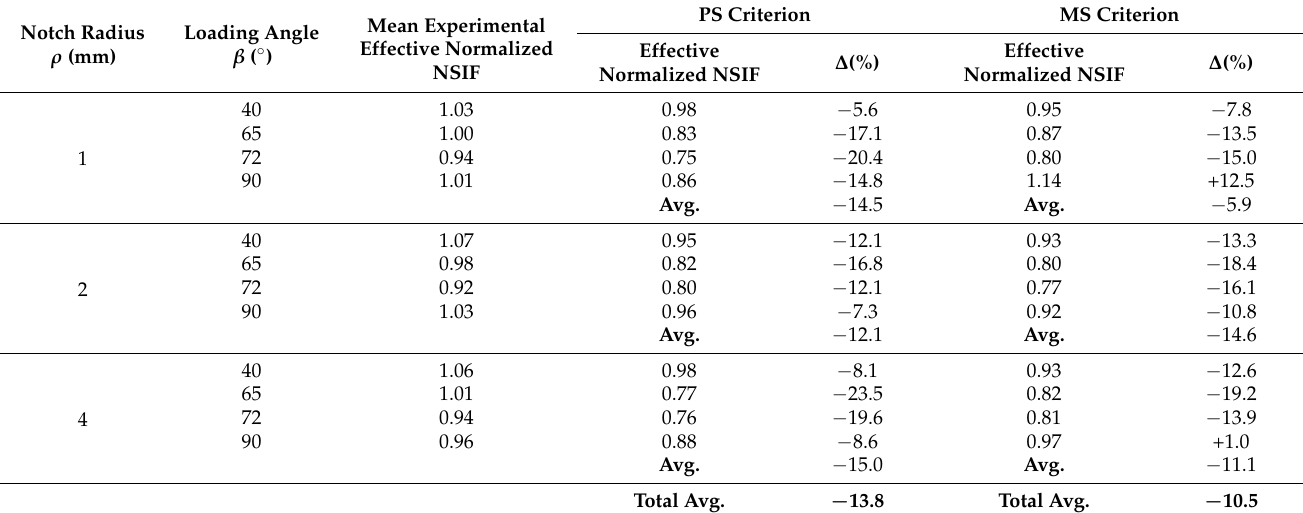
Table 3. Theoretical and experimental values of the effective normalized NSIF for the U-notched spruce wood samples, together with the percent